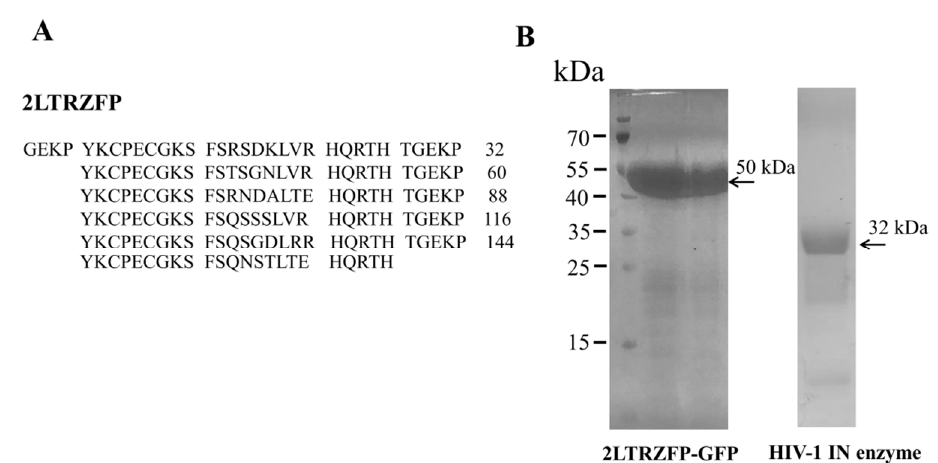
Figure 1. Amino acid sequence, production and purification of 2LTRZFP-GFP and HIV-1 IN enzyme. ( A ) Amino acid sequences of 2LTRZFP. ( B ) SDS-PAGE analysis of 2LTRZFP-GFP and HIV-1 IN purified by HisTrap HP His tag protein purification column. The molecular weights of recombinant 2LTRZFP-GFP and HIV-1 IN are 50 and 32 kDa, respectively.